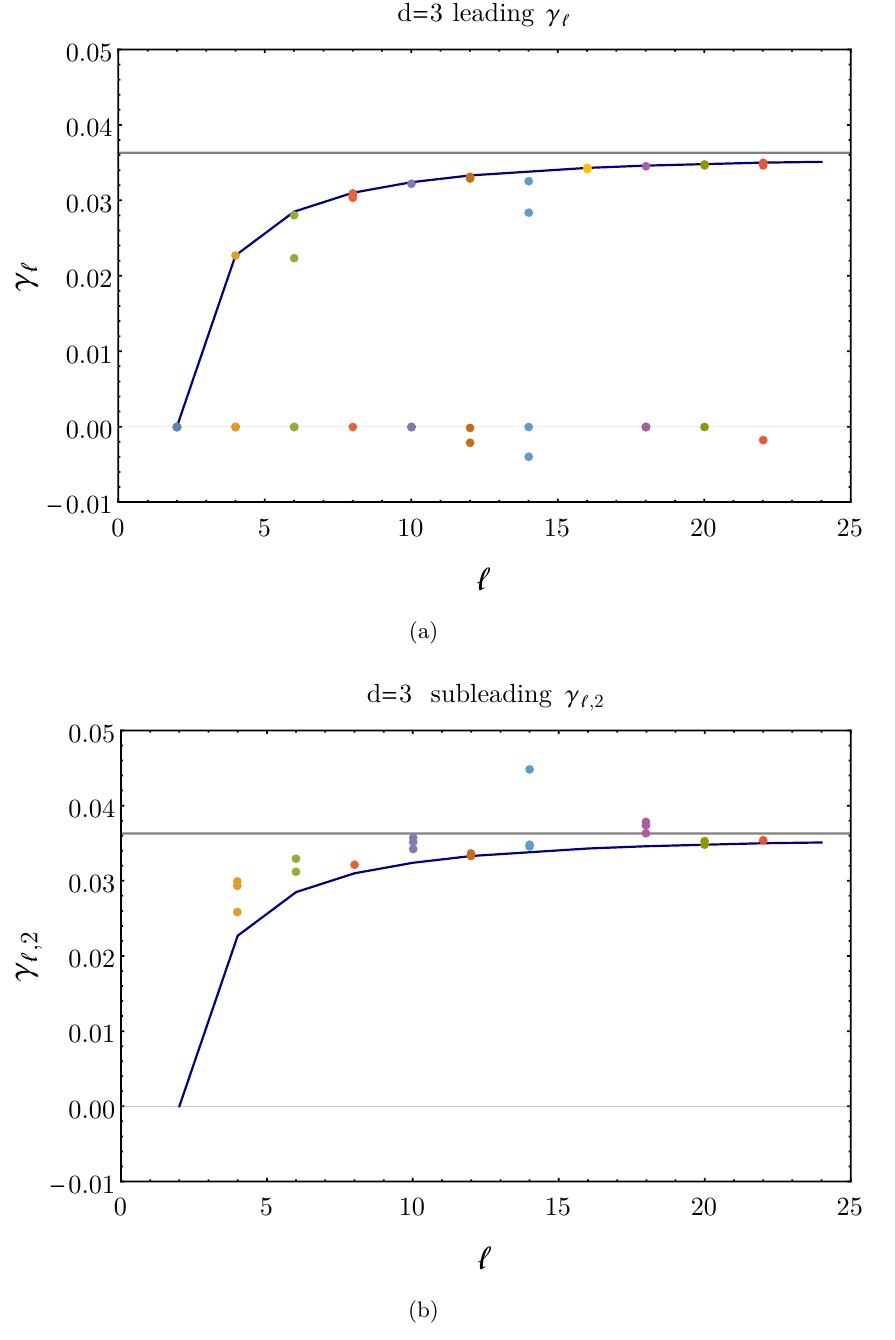
Figure 12 . Anomalous dimension of leading (a) and subleading (b) twists with 2 (cid:20) ‘ (cid:20) 22 in d = 3 compared with three-correlator results (blue curve) and ‘ ! 1 asymptotic value (gray line).